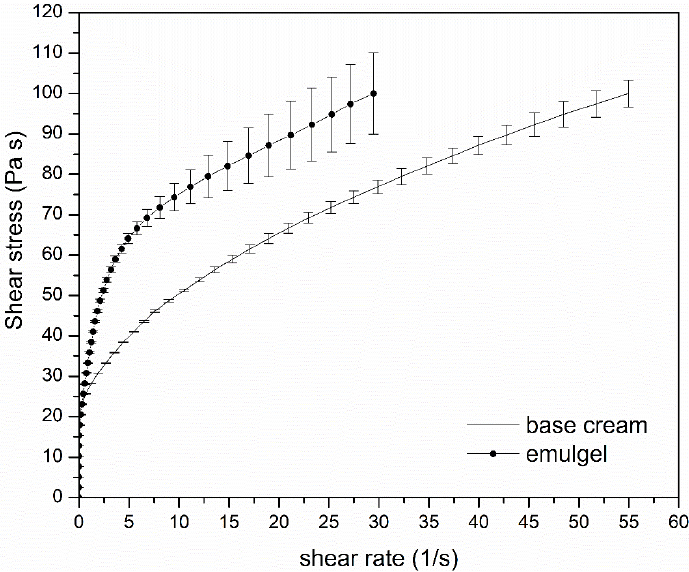
Figure 15. Rheogram of the base cream and of the developed emulgel.